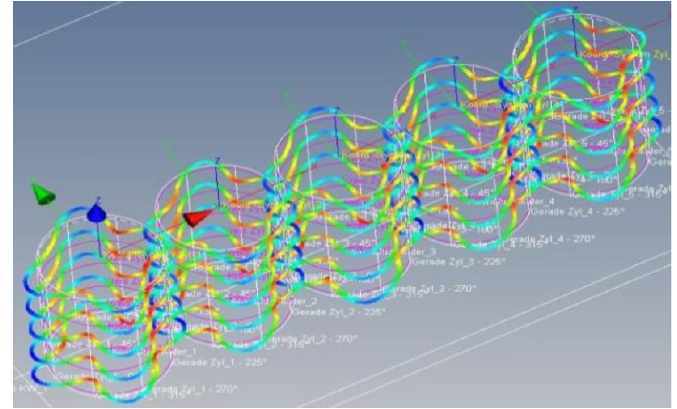
Figure 2. Repeat accuracy: Result of the measurement of a demonstrator component with five identically manufactured form bores.